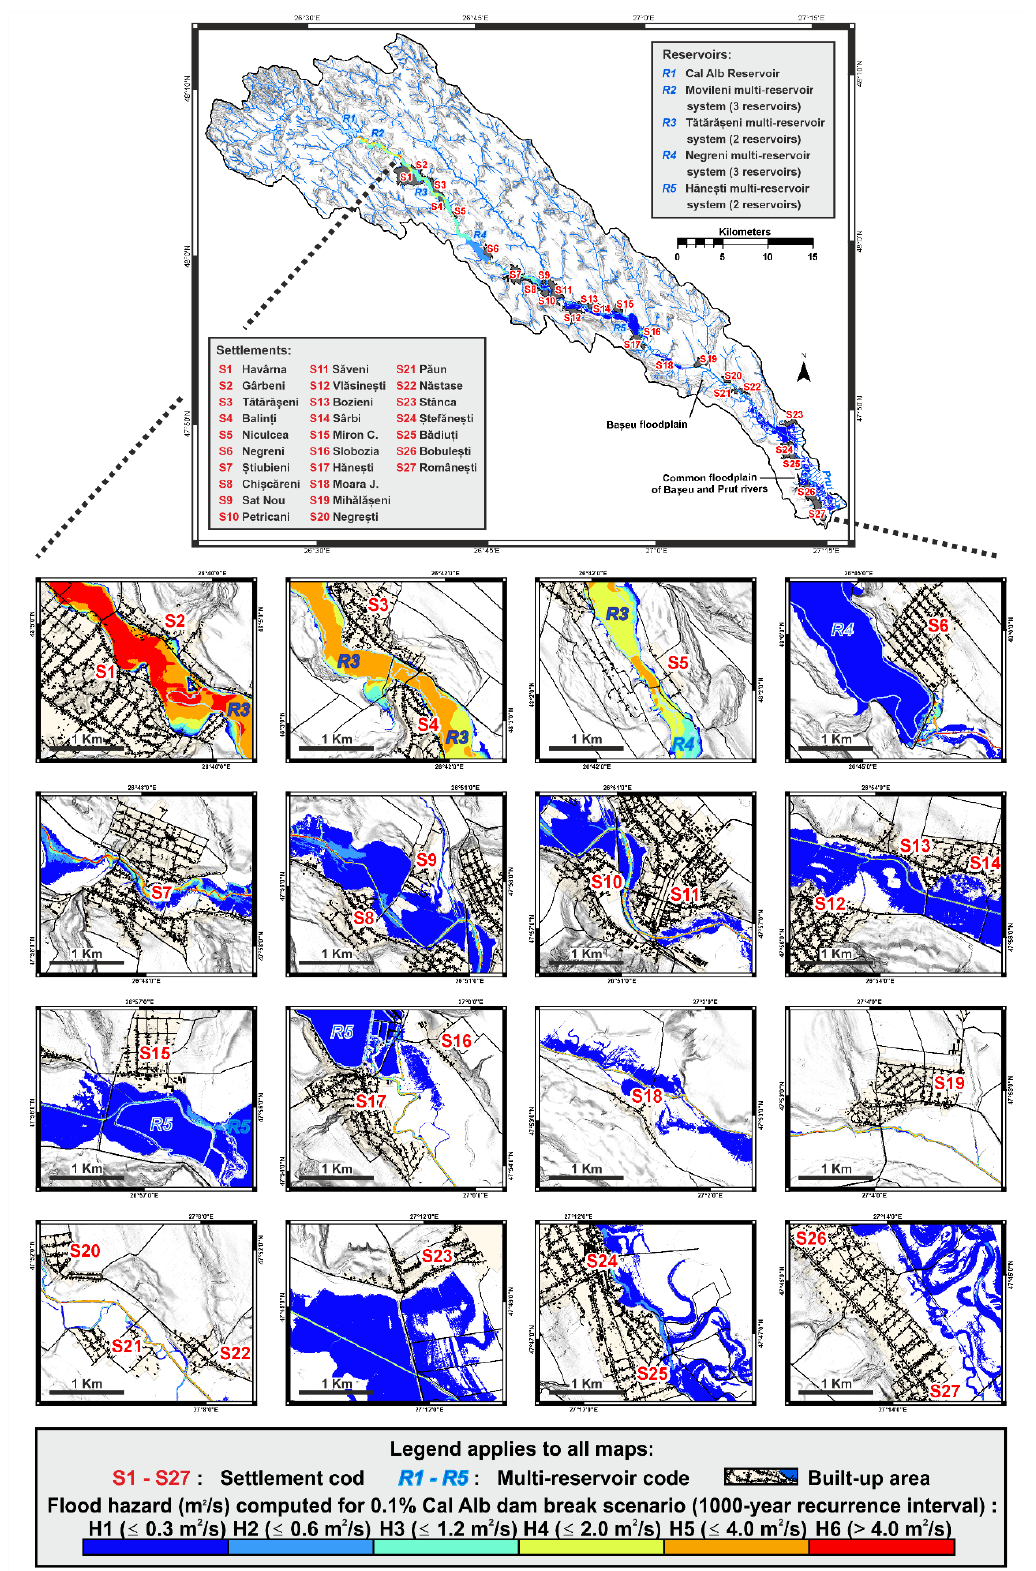
Figure 7. D × V (m 2 /s) hazard classes according to the AIDR criteria [46] within built-up area of 27 settlements located downstream of the Cal Alb reservoir computed for the worst dam break scenarios with the 0.1% (1000-year) recurrence interval.